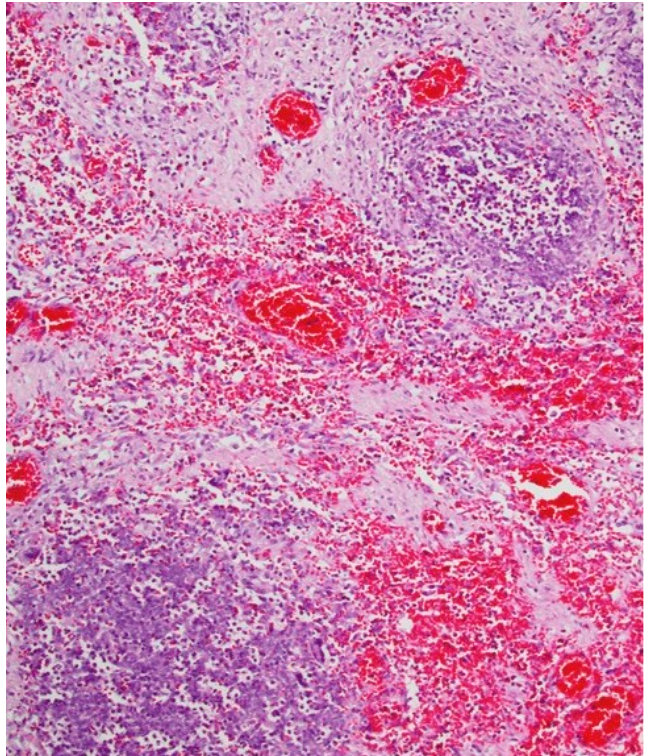
Figure 3. Mucosal inflammation and necrotic areas of the stomach.